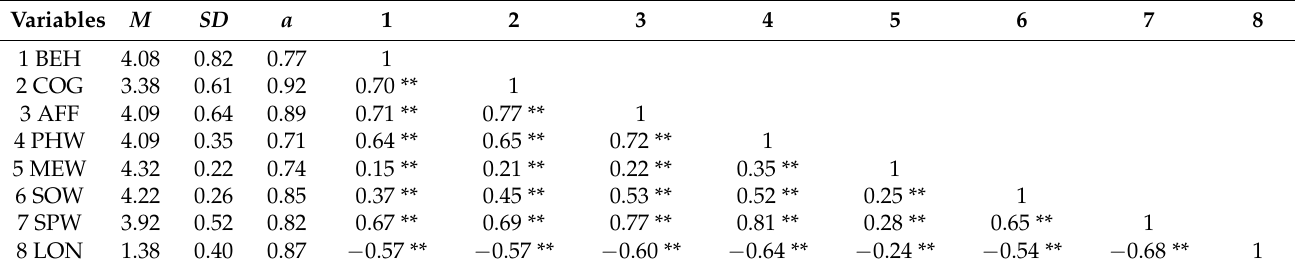
Table 2. Measurement model